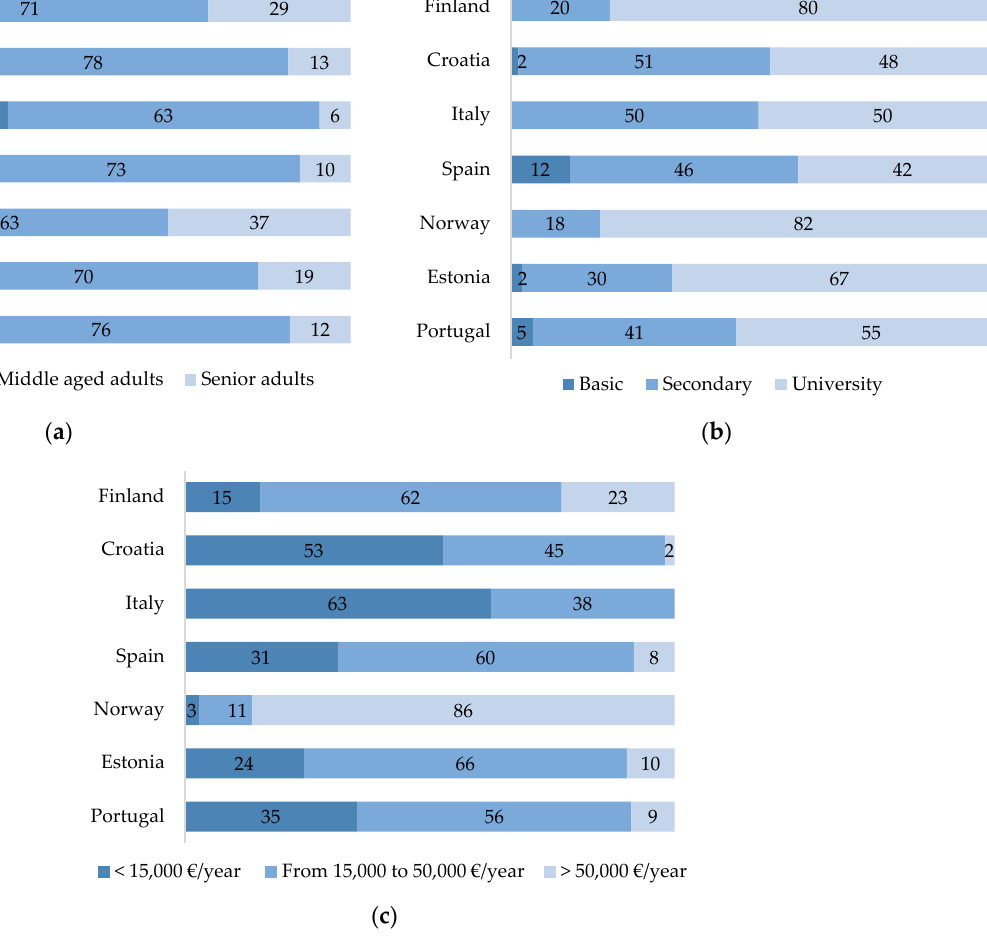
Figure 2. Relative distribution of age ( a ), education level ( b ), and income ( c ) by country (%).